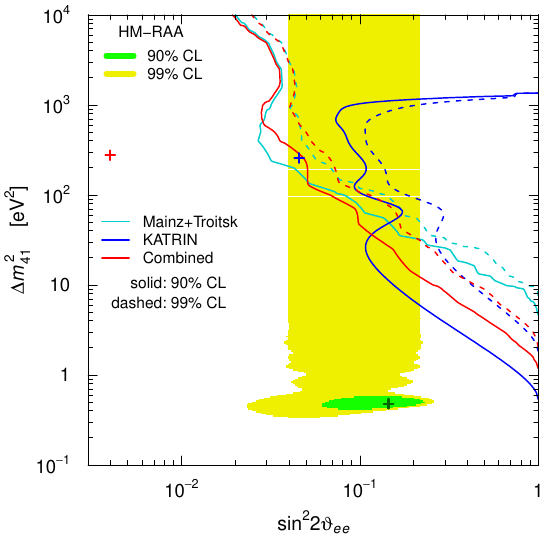
Figure 2 . 90% and 99% CL exclusion curves in the (sin 2 2 # ee ; (cid:1) m 2 ) plane obtained from the 41 analysis of KATRIN data with free m (cid:12) and m (cid:12) = 0. Also shown are the exclusion curves of the Mainz [5] and Troitsk [6, 7] experiments obtained in ref. [8] and the combined exclusion curves. The green and yellow regions are allowed at 90% and 99% CL by the neutrino oscillation solution [28] of the Huber-Muller reactor antineutrino anomaly (HM-RAA). The crosses indicate the best-(cid:12)t points.